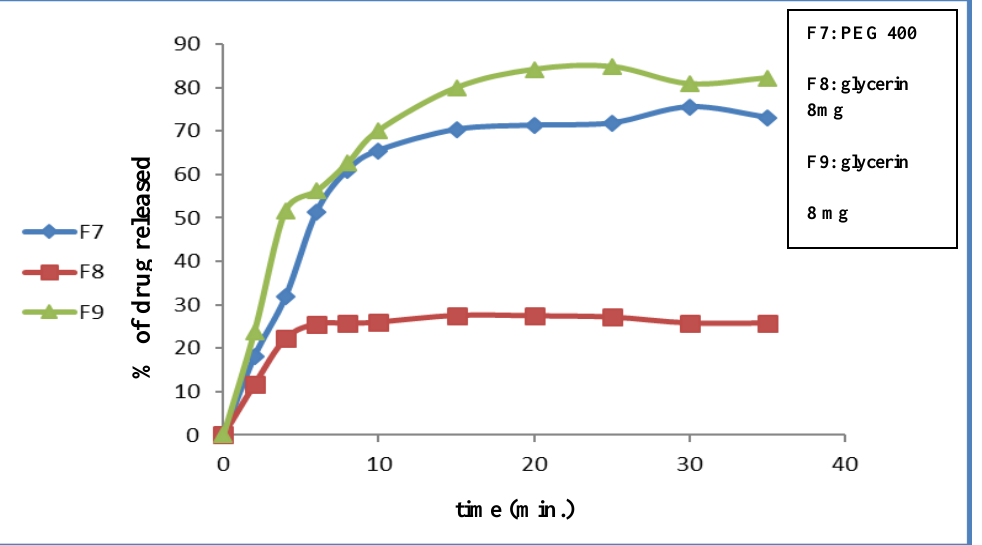
Figure 5: Effect of plasticizer type and concentration on the release profile of Flurbiprofen in F7, F8and F9 phosphate buffer pH 6.8 and 37